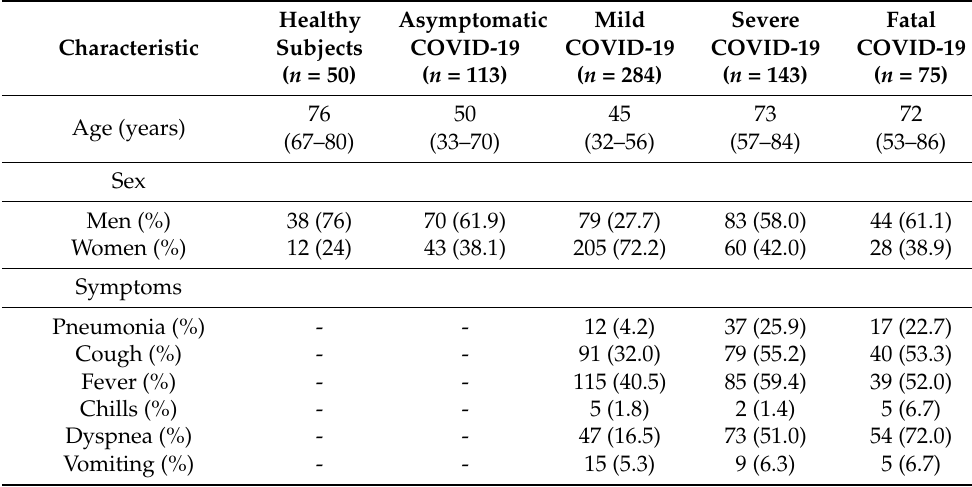
Table 1. Demographic and clinical characteristics of studied